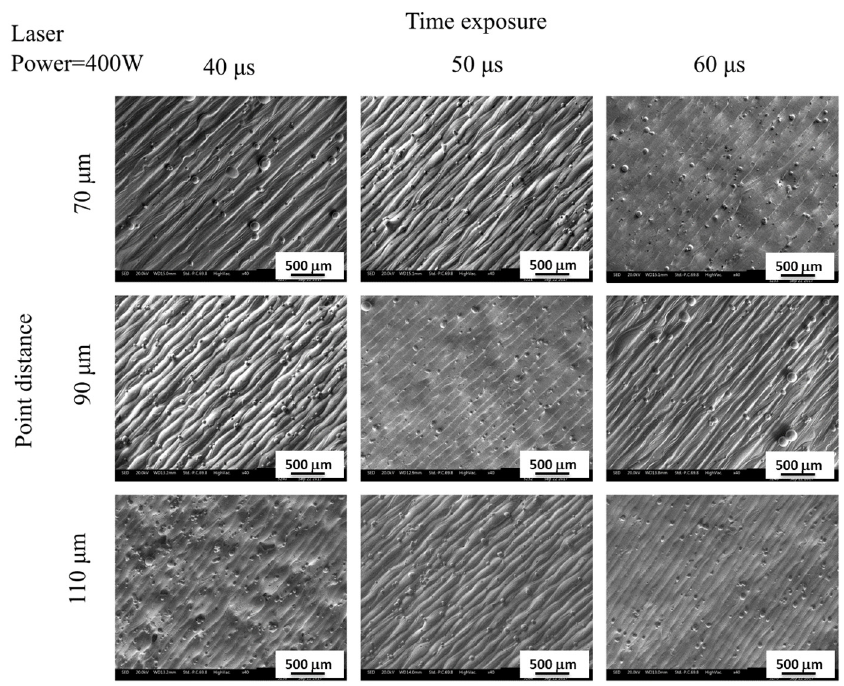
Figure 1. Scanning electron microscopy (SEM) micrographs of top surfaces of blocks fabricated with a laser power of 400 W.